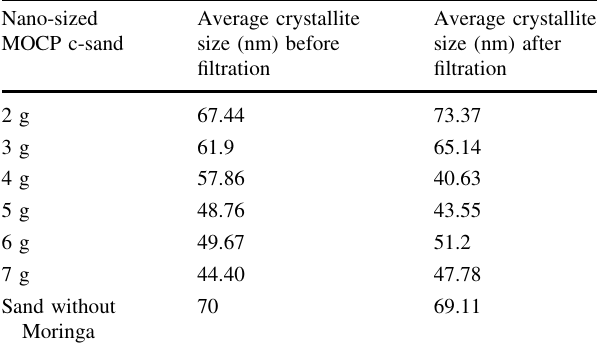
Table 4 Average particle size range of MOCP coated on the sand before and after filtration based on the SEM results (Fig. 6) MOCP